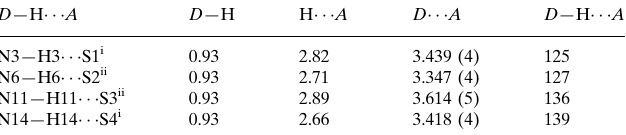
Hydrogen-bond geometry (A˚ , (cid:4)